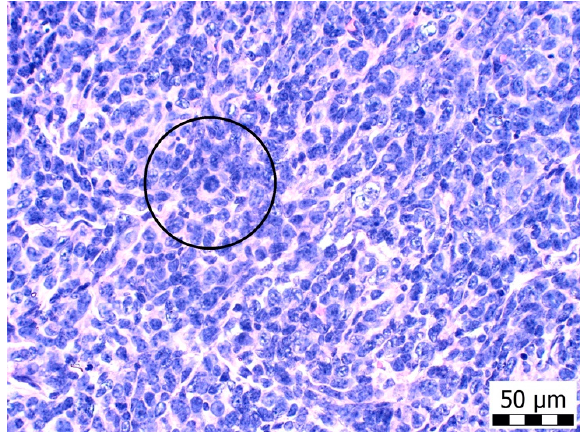
Figure 3. The mitotic activity index after the treatment with C. zeylanicum in 4T1 tumors in Balb/c mice. The mitotic figures (prophases, metaphases, anaphases) are highlighted in circles; H&E staining; magnification ×400.